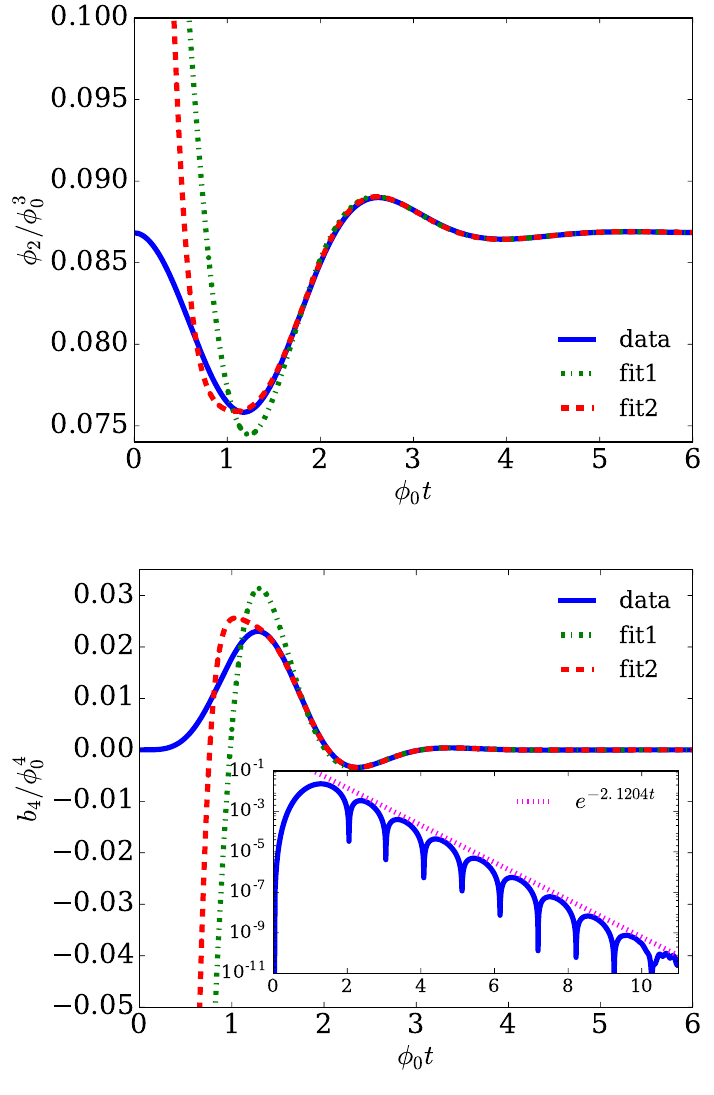
Figure 4 . (cid:30) 2 and b 4 as functions of time for a z -independent con(cid:12)guration with (cid:30) M = 10 and E = 0 : 379686 (cid:30) 4 , with initial data as speci(cid:12)ed in (4.2). The solid blue curve corresponds to data 0 from the code, the dash-dotted green curve corresponds to a (cid:12)t to the data using one QNM, and the dashed red curve corresponds to a (cid:12)t using two QNMs as explained in the text.